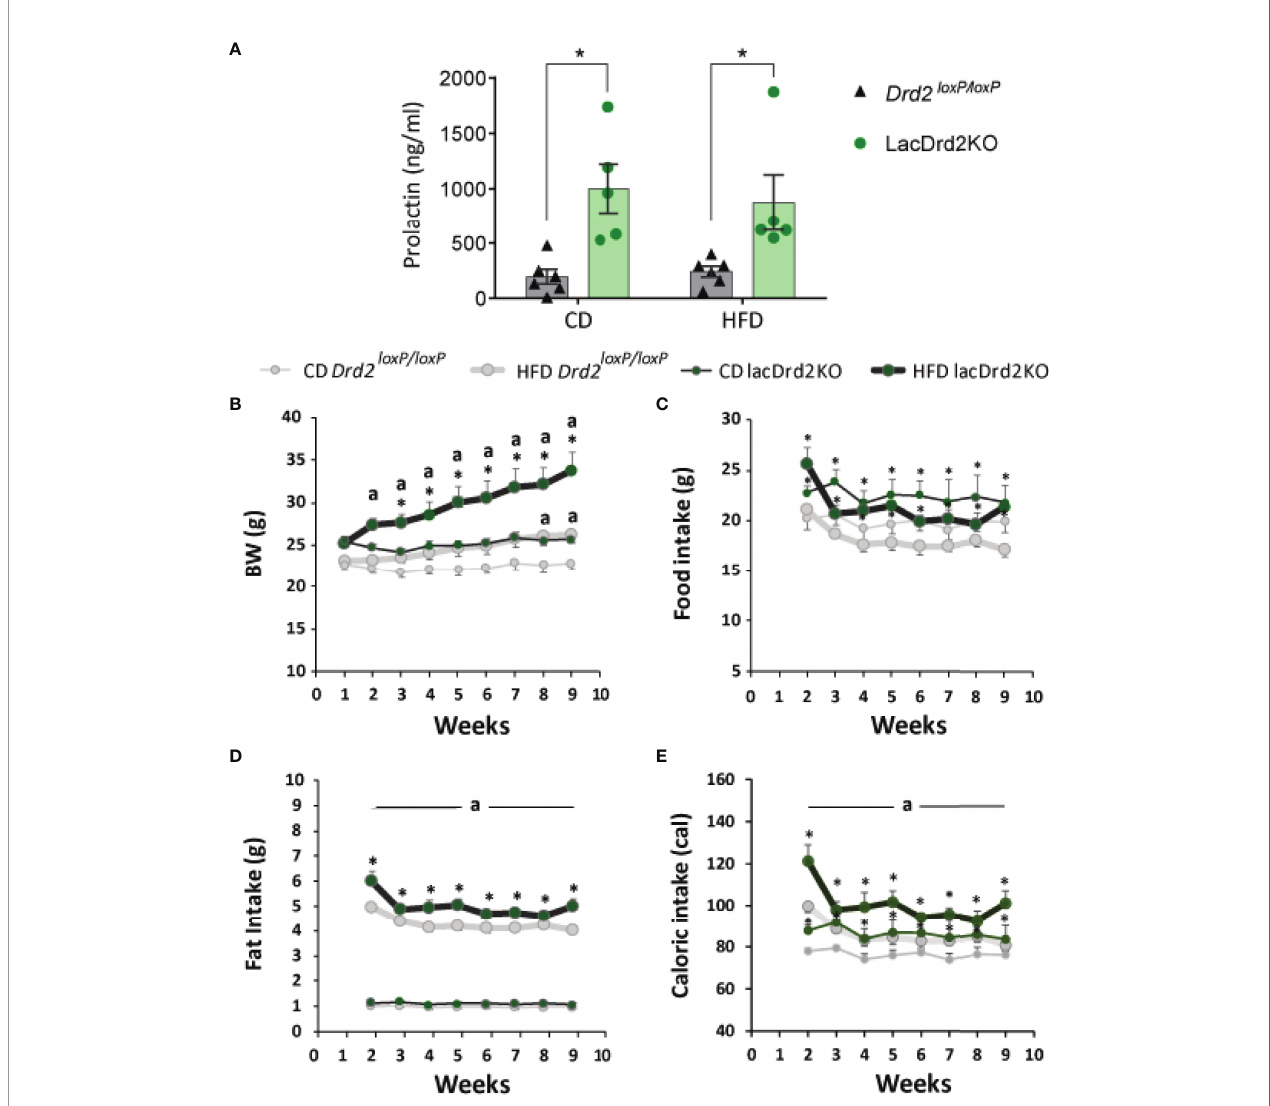
FIGURE 2 | Serum prolactin, body weight and food intake in response to a high-fat diet and hyperprolactinemia. (A) Serum prolactin levels in ng/ml at the end to the feeding protocol (Two Way Anova, * P ≤ 0.05 vs. diet- matched Drd2 loxP/loxP mice). (B) Weekly measured body weight in grams; (C) food intake in grams (g); (D) fat intake in grams (g); and (E) energy intake in calories consumed (cal) (n= 6, and 6 Drd2 loxP/loxP control diet (CD) and high fat diet (HFD) respectively, and 5 and 5 for lacDrd2KO mice fed with CD or HFD, respectively. Three-way ANOVA, “ a ” = P ≤ 0. 05 vs. genotype- and time- matched mice fed with CD * P ≤ 0.05 vs diet- and time-matched Drd2 loxP/loxP